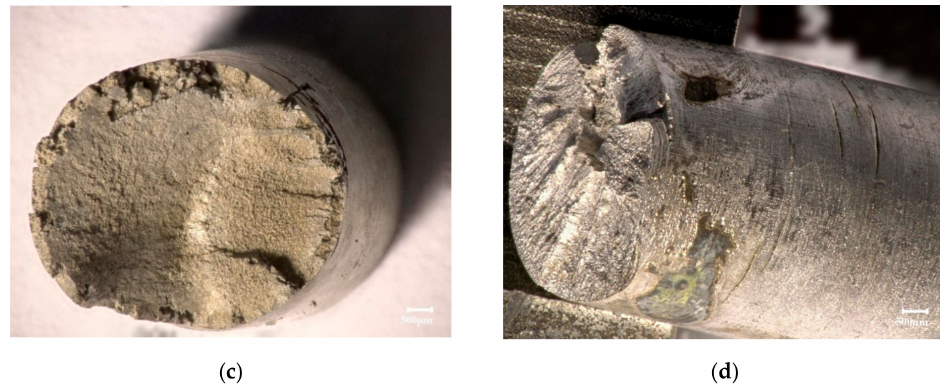
Figure 8. The surface morphologies of the alloy in air ( a ), distilled water ( b ), NaCl ( c ), and Na 2 SO 4 ( d ) aqueous solutions.